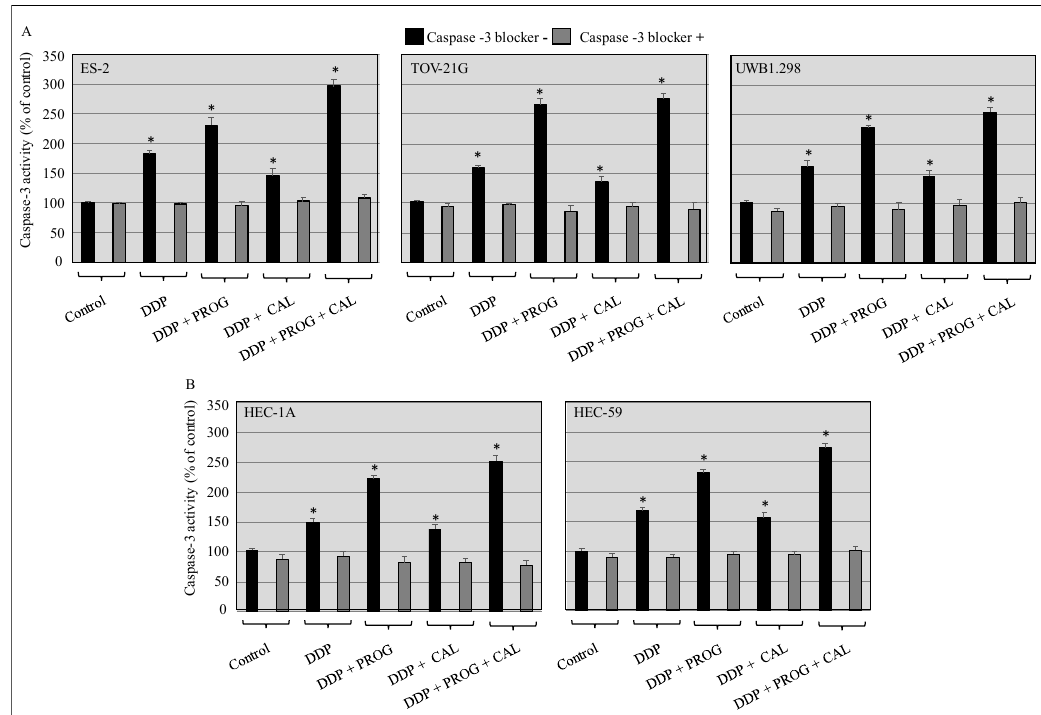
Figure 2. Progesterone-calcitriol combination enhanced DDP induced apoptosis. The ovarian ( A ) and endometrial ( B ) cancer cells were pre-treated with or without caspase-3 blocker (z-DEVD-fmk, 25 µ M) and then treated with DDP (6 µ M) either with progesterone (20 µ M), calcitriol (30 nM), or the combination of the two for 76 h. Lysates from treated and control cells were subjected to caspase-3 activity assays. Data are shown as the mean ± SEM of three independent experiments. An asterisk * indicated a statistically significant difference between the control and treated cancer cells ( p < 0.05).